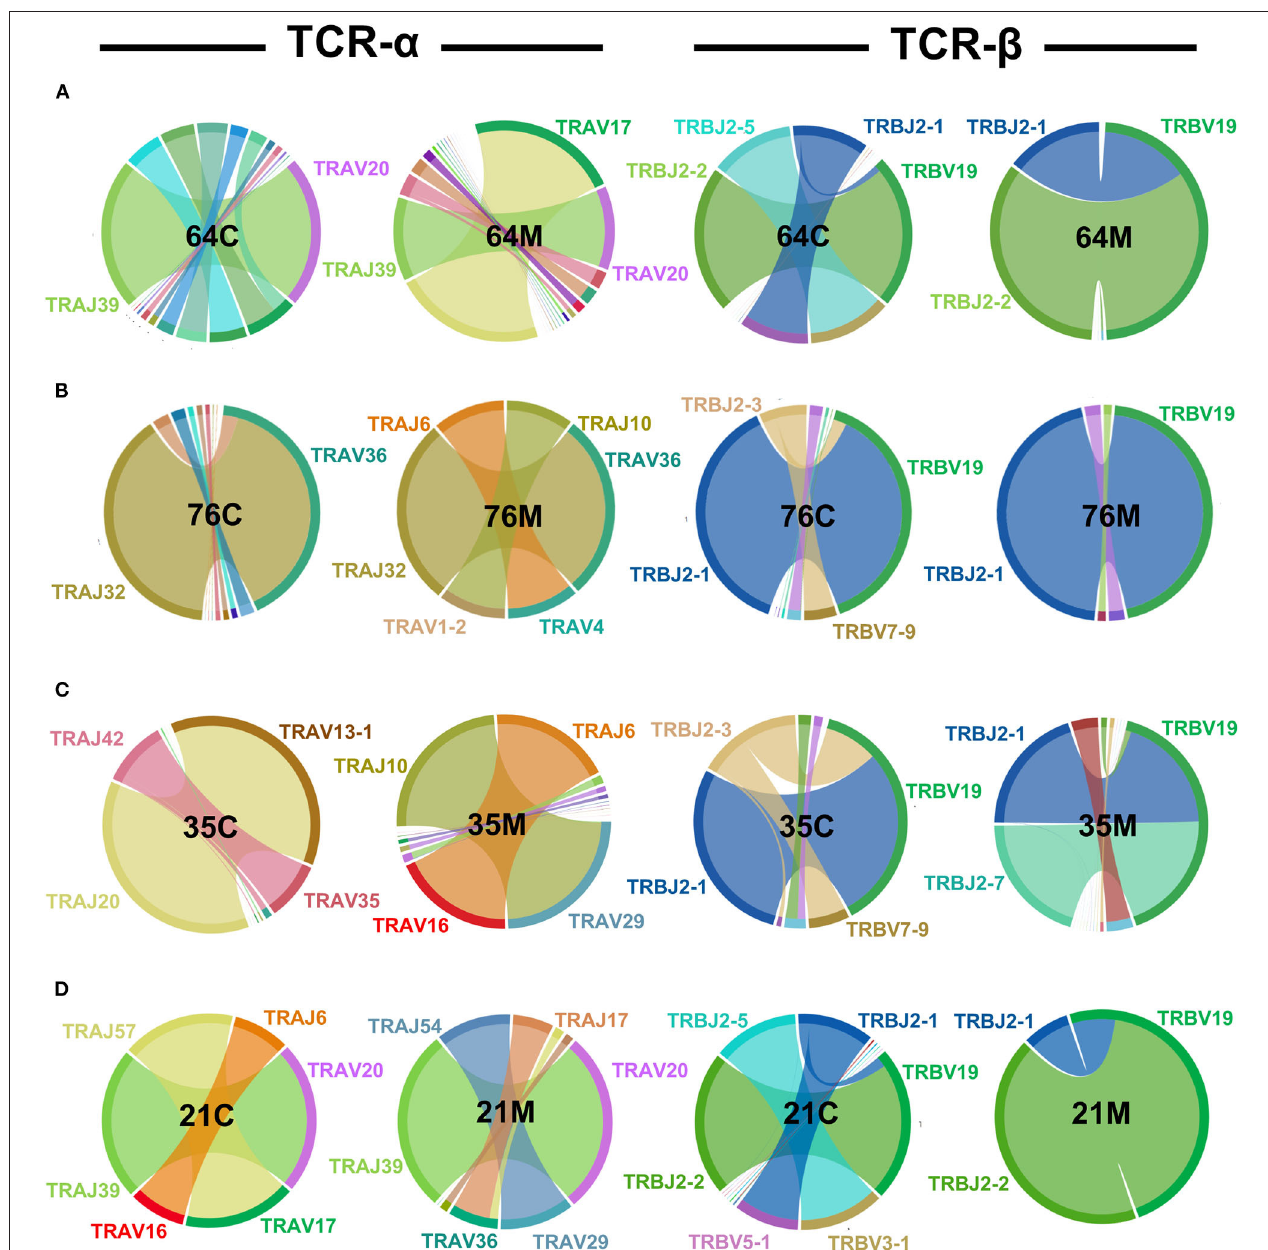
FIGURE 2 | TCR- α and - β chain bias in NW8-specific CD8T cell responses is manifest in children and adults alike. CD8T cells were stained with HLA-B*44:03/NW8 tetramer and sorted for TCR- α and - β sequencing, as described in Materials and methods. TRAV-TRAJ (left) and TRBV-TRBJ (right) gene co-occurrence wheels are shown for CMV/HIV infected children, and their mothers. A single time point is shown for every individual, chosen so that the mothers and the children would be of similar age in their respective group. The size of the arcs is proportional to V or J frequency. The area joining any V-J pair is proportional to the co-occurrence frequency of that pair. Co-occurrence (“circos”) wheels were generated by VDJviz (40). Gene segments encoding dominant clonotypes are highlighted in colours matching the corresponding section in the wheel. Gene segment co-occurrence is shown for (A) the 64 family: 64M, the mother; 64C, the child. (B) the 76 family: 76M, the mother; 76C, the child. (C) the 35 family: 35M, the mother; 35C, the child. (D) The 21 family: 21M, the mother; 21C, the child. the TRAV17-TRAJ57 pair, seen in 64M and 21C. Similarly,